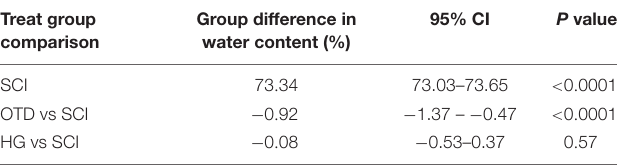
TABLE 3 | Treatment effect estimation using a linear regression model.